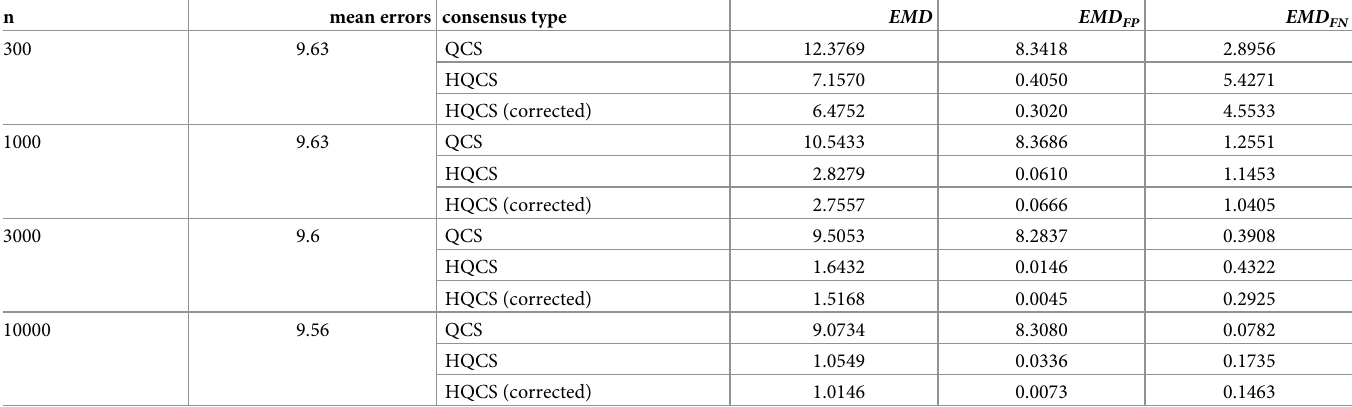
Table 1. EMD metrics for various numbers of reads, averaged across all time points. “mean errors” gives the average number of errors in the reads, estimated from the simulated Phred scores. n